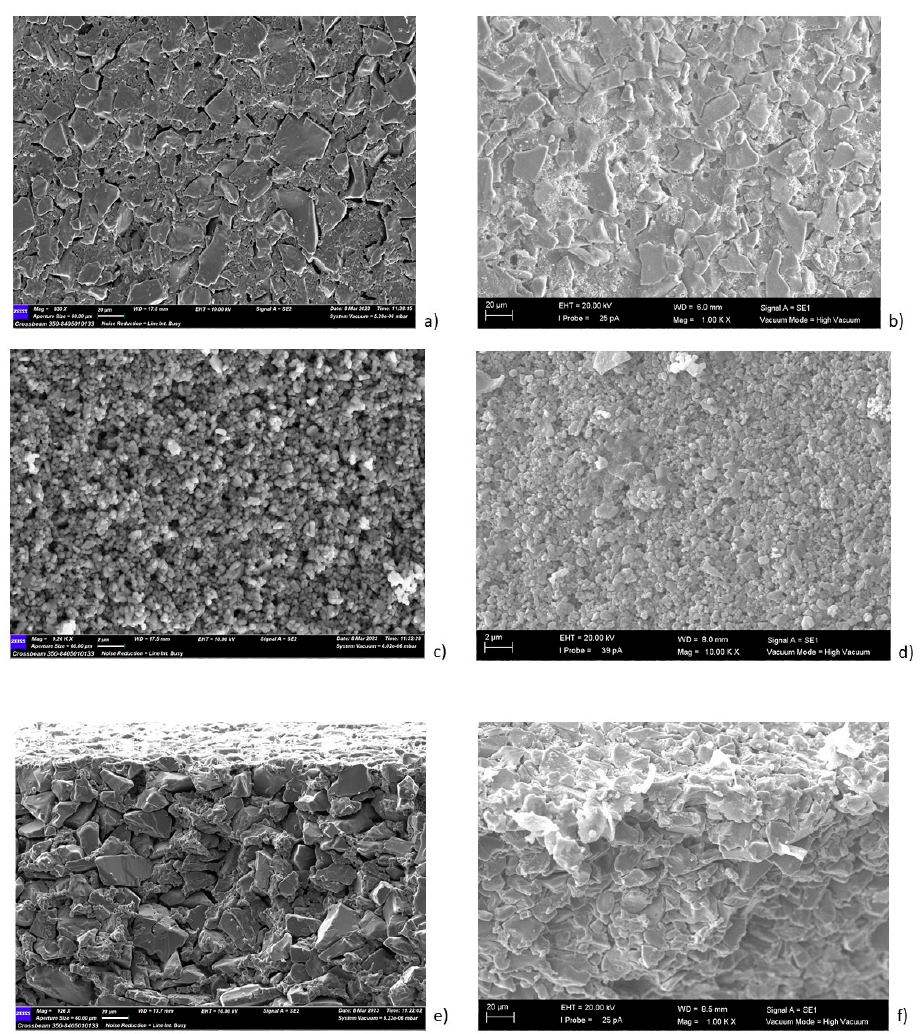
Figure 5. Morphological analysis of the ( a ) external surface, ( c ) internal layer and ( e ) cross-section of the pristine membrane; ( b ) the external surface, ( d ) internal layer and ( f ) cross-section of the photocatalytic membranes.